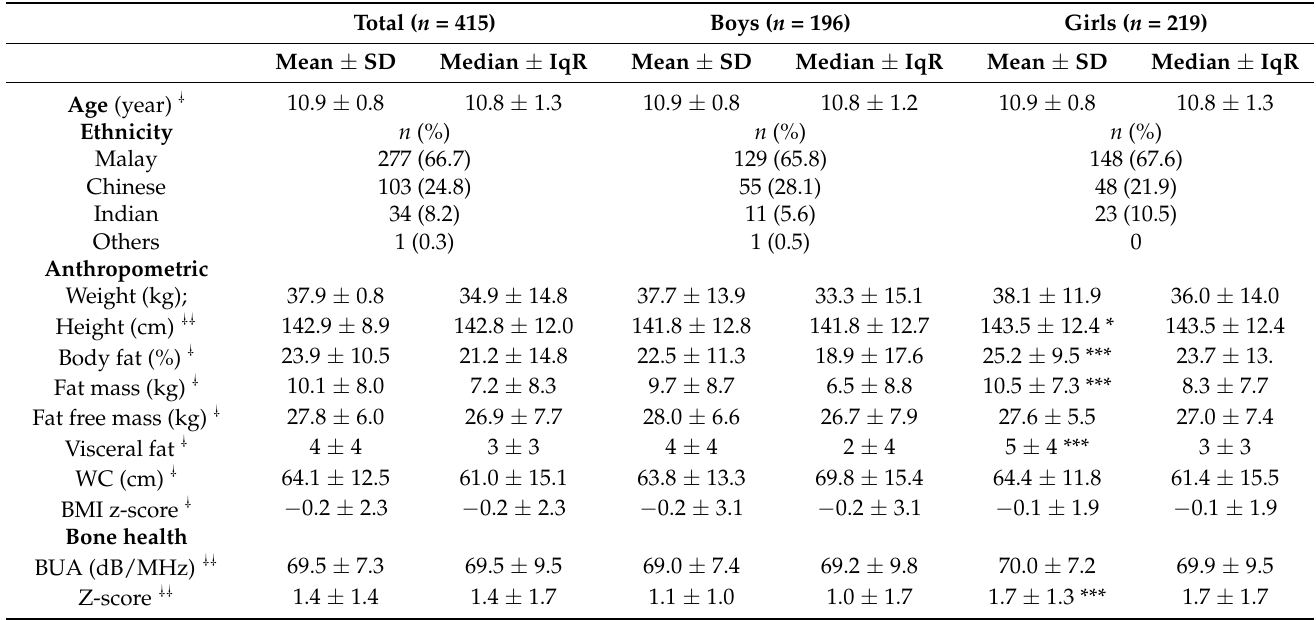
Table 1. Demographic characteristics, anthropometric and bone outcome variables of schoolchildren ( n = 415). Total ( n = 415)